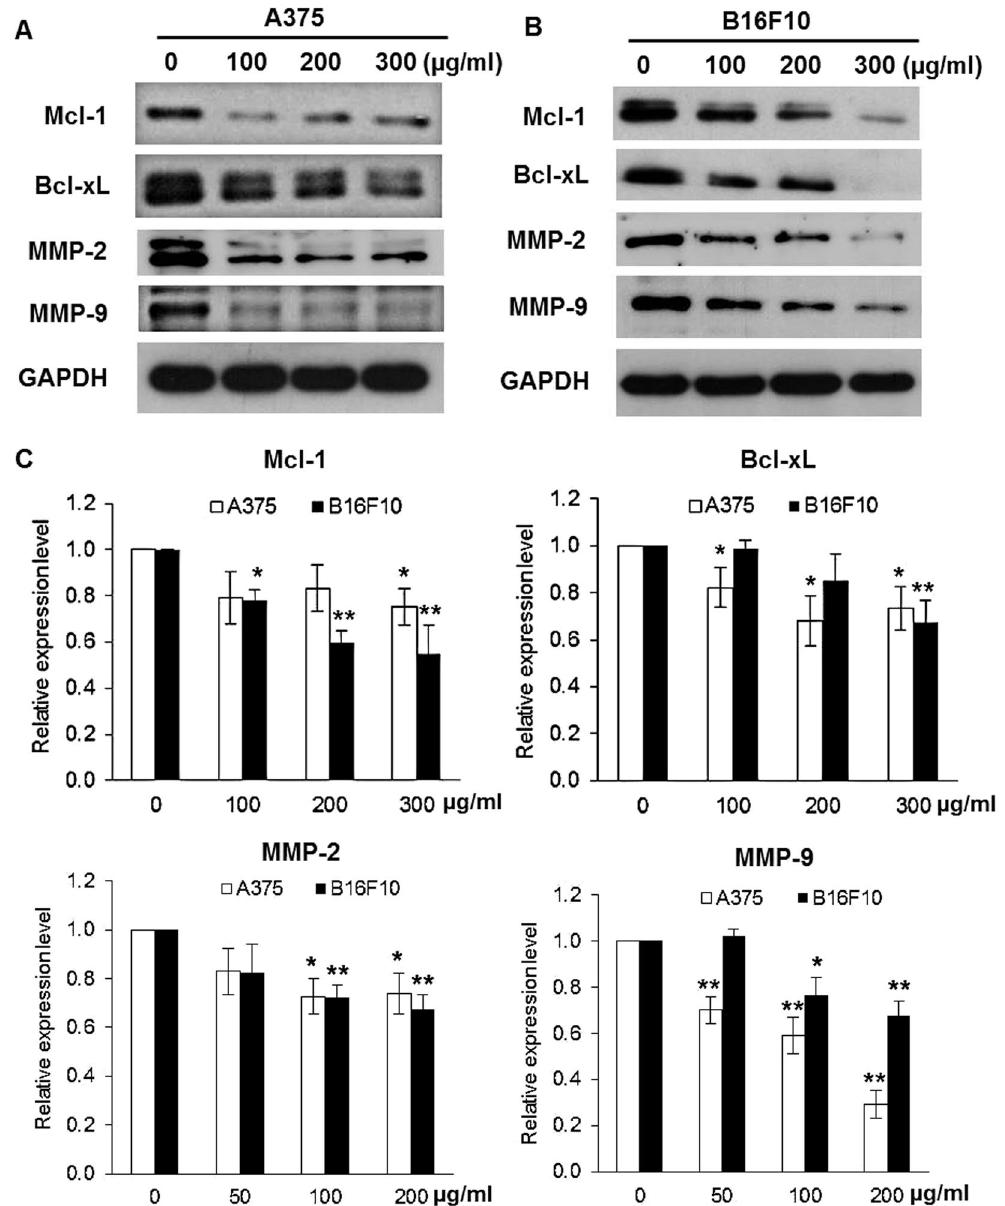
Figure 6. SLE downregulated the expression levels of STAT3 target genes in melanoma cells. Protein expressions of Mcl-1, Bcl-xL, MMP-2 and MMP-9 in A375 ( A ) and B16F10 ( B ) cells. Cells were treated with indicated concentrations of SLE for 48 h. Protein levels were examined by immunoblotting and cropped blots were displayed. The original blot images were shown in Supplementary Dataset. ( C ) The mRNA expressions of Mcl-1, Bcl-xL, MMP-2 and MMP-9 in A375 and B16F10 cells. Cells were treated with indicated concentrations of SLE for 24 h. Total RNA was extracted with Trizol. Gene expression levels were detected using RT-PCR analysis. Data were shown as fold change ± SD of three independent experiments, * P < 0.05, ** P < 0.01 versus vehicle